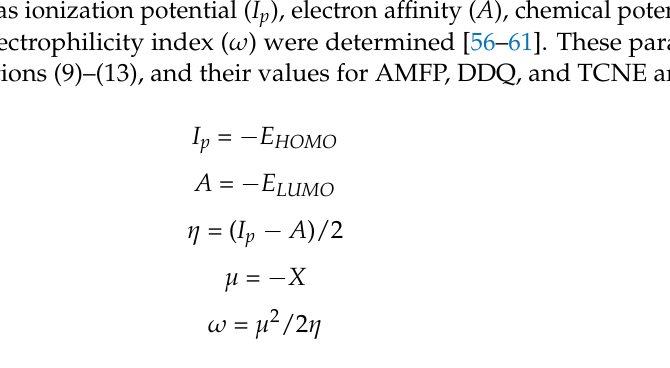
Table 7. Reactivity descriptors (eV) of the free DDQ, TCNE, and AMFP using the WB97XD method. Parameter DDQ TCNE AMFP HOMO −